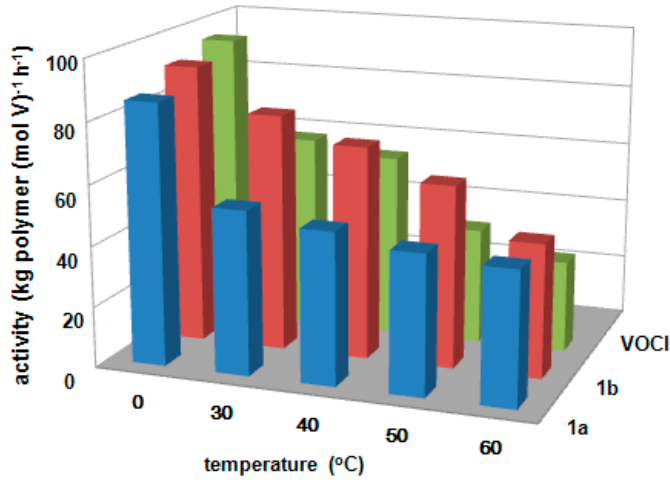
Figure 2. Effect of polymerization temperature on activity of vanadium-based catalysts in ethylene/propylene polymerization.